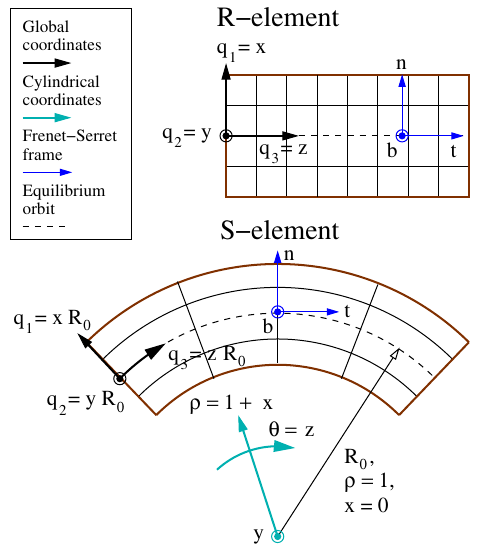
FIG. 1. Illustration of R- and S-elements. Elements are shown in brown. Global curvilinear coordinates with associated grid lines are shown in black. Black dashed line represents an equilibrium orbit. An example of the Frenet-Serret frame attached to an equilibrium orbit is drawn in blue colors. For S-element, an additional right-handed normalized cylindrical system is added and shown in